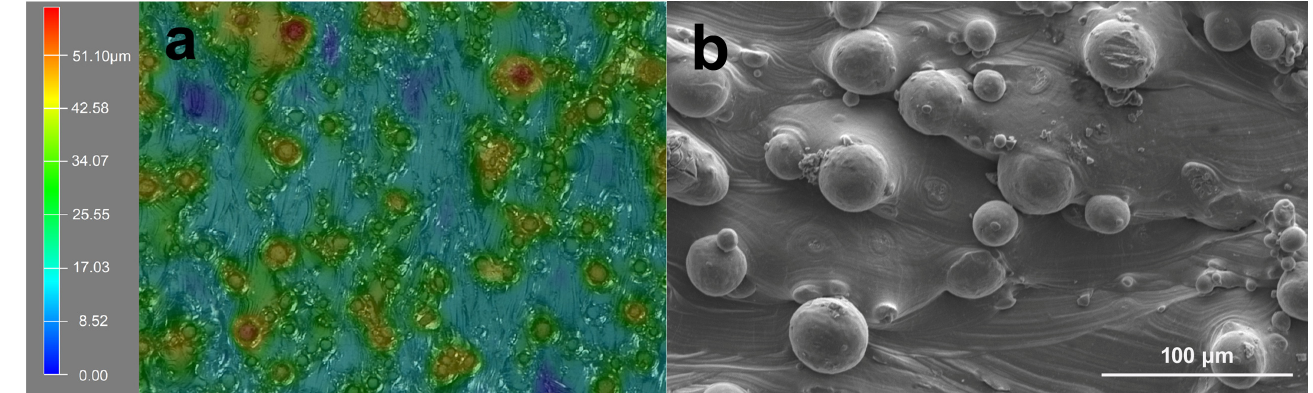
Figure 1. Representation of ( a ) optical surface profiles and ( b ) SEM morphology of SLM-Ti substrate.